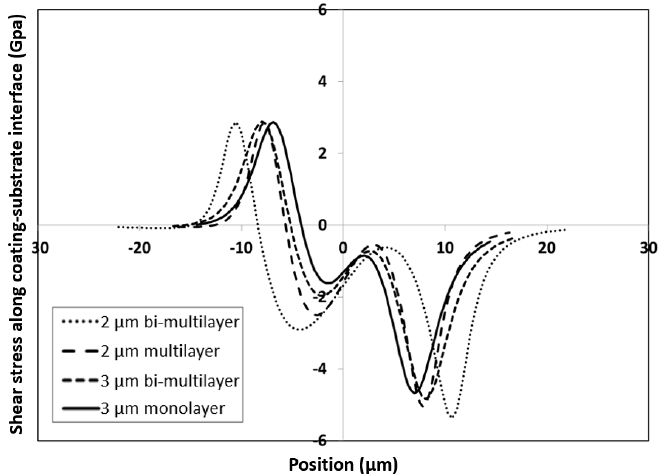
Figure 7. Simulated interfacial shear stresses at L c2 failure. The scratch direction is from left to right.